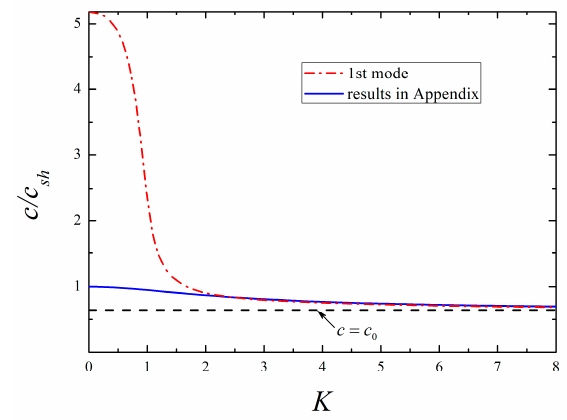
Figure 3. Comparison of the 1st mode for the present nanostructure and the SH surface waves for a piezoelectric half-space with surface effects.